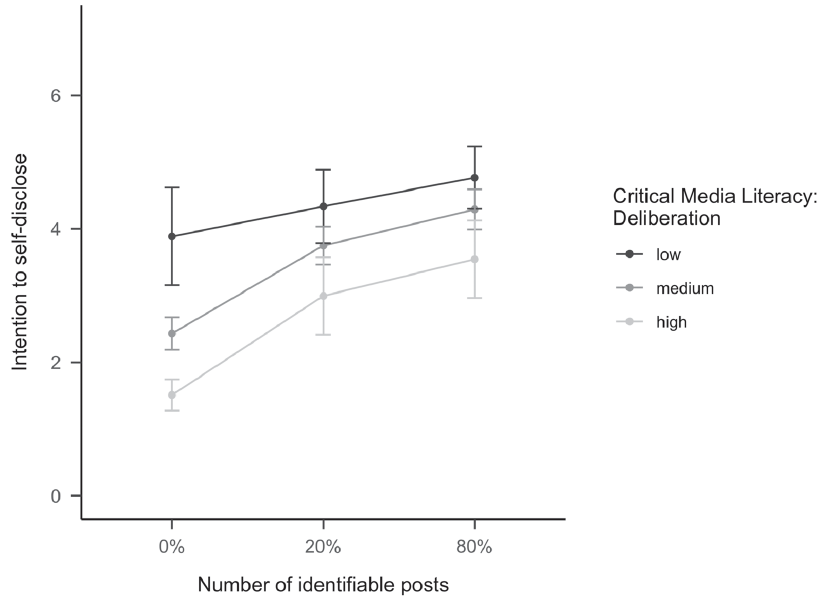
Fig 3. Critical media literacy (deliberate social media use) influences the effect of number of identifiable posts on norm perceptions on the intention to self-disclose (Study 1). The error bars represent 95% confidence intervals. The moderation analysis was conducted using the continuous moderator. Here, we exemplify the moderation effect by showing exemplary results for participants with medium (= average critical media literacy in the sample), high (= M + SD), and low (= M—SD) levels of